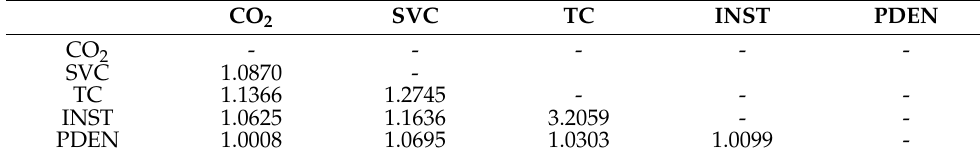
Table 3. VIF Matrix for Study Variables.